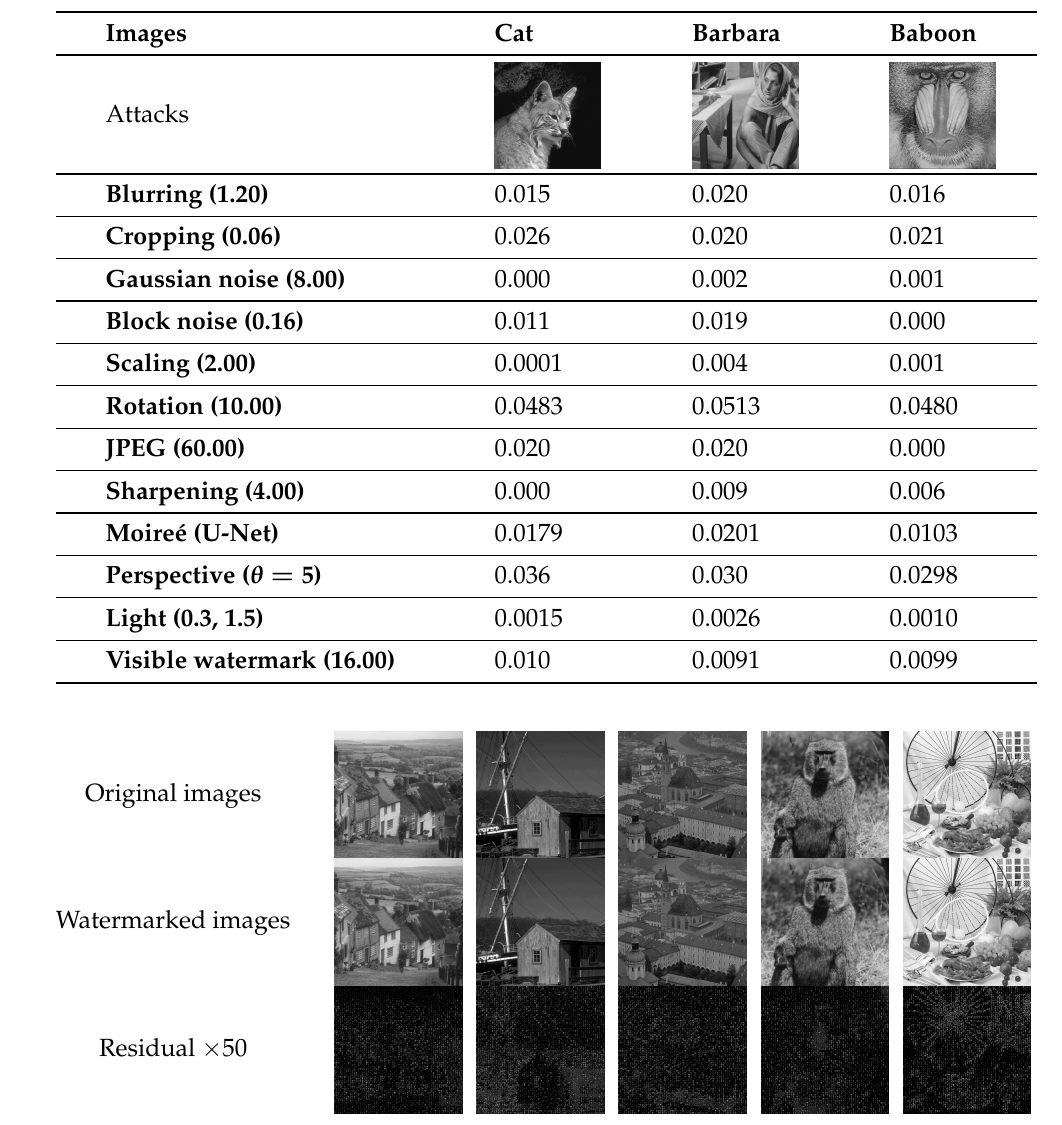
Figure 14. The results of images watermark embedding and the residual for original and water- marked